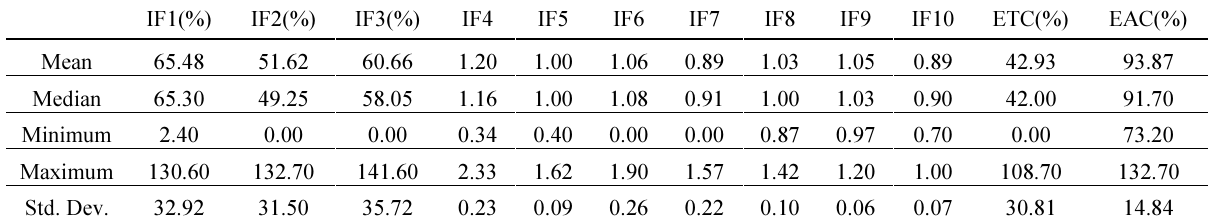
Table 3. Descriptive statistics of historical data